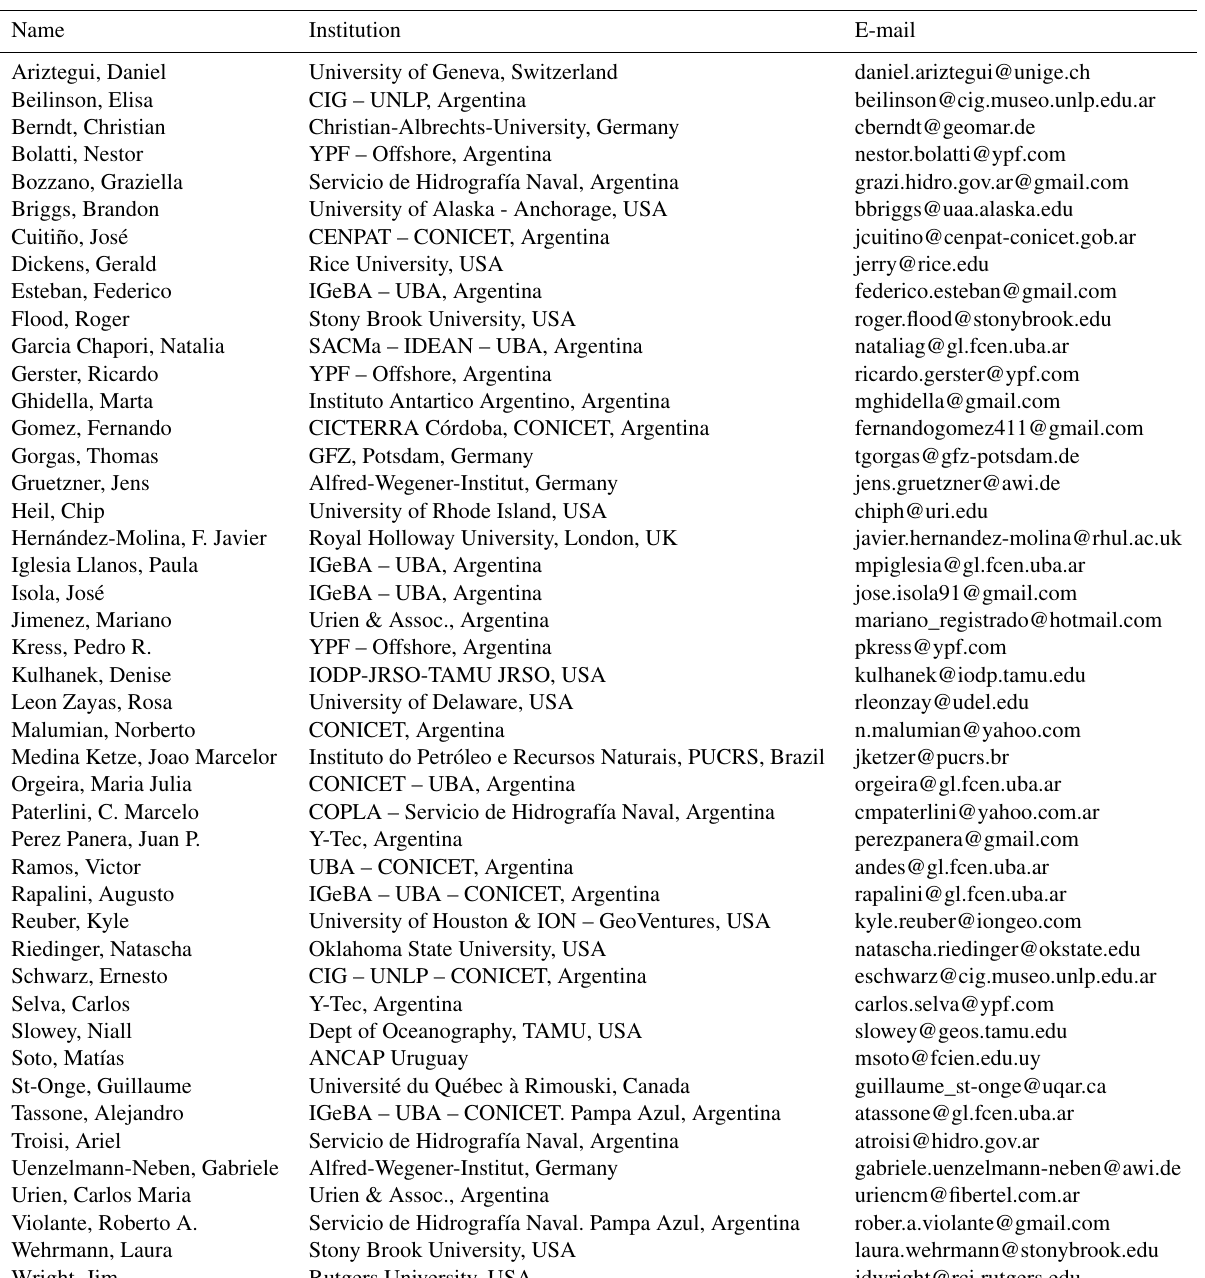
Table 1. IODP workshop: developing scientific drilling proposals for the Argentina Passive Volcanic Continental Margin (APVCM) – basin evolution, deep biosphere, hydrates, sediment dynamics and ocean